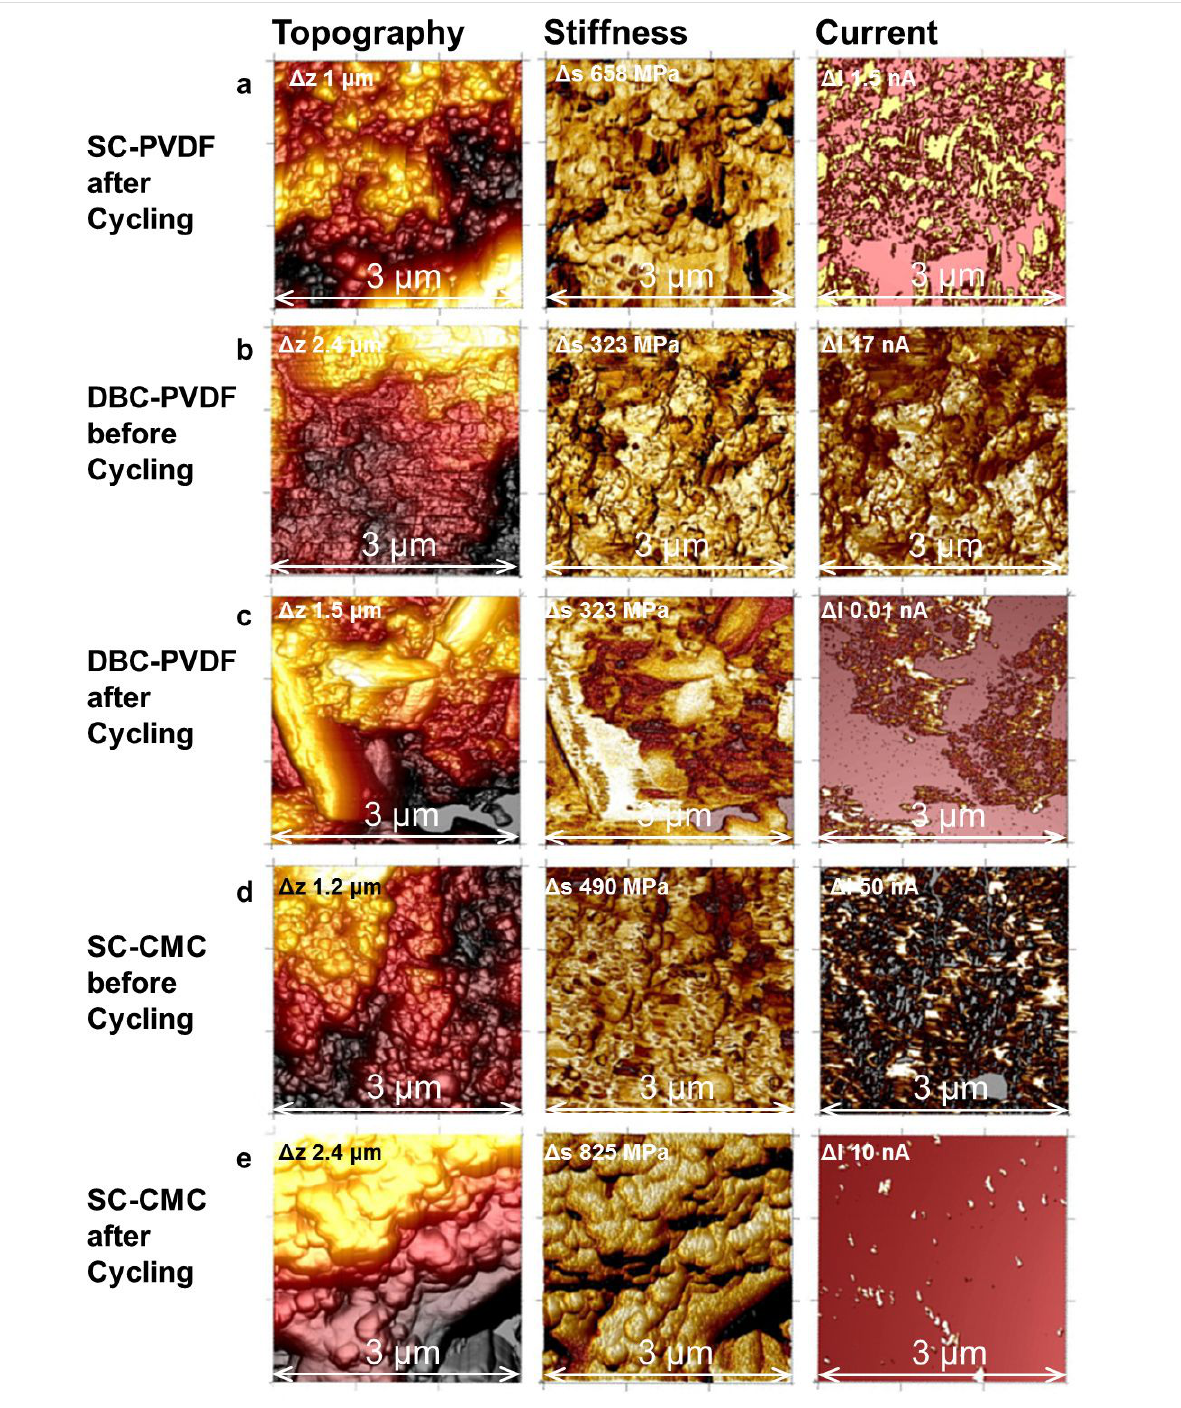
Figure 7: AFM image of topography, DMT modulus, and QNM™ current of a) SC-PVDF after cycling b) DBC-PVDF before cycling, c) DBC-PVDF after cycling, d) SC-CMC before cycling and e) SC-CMC after cycling. The scale bar is given as a value in the image.